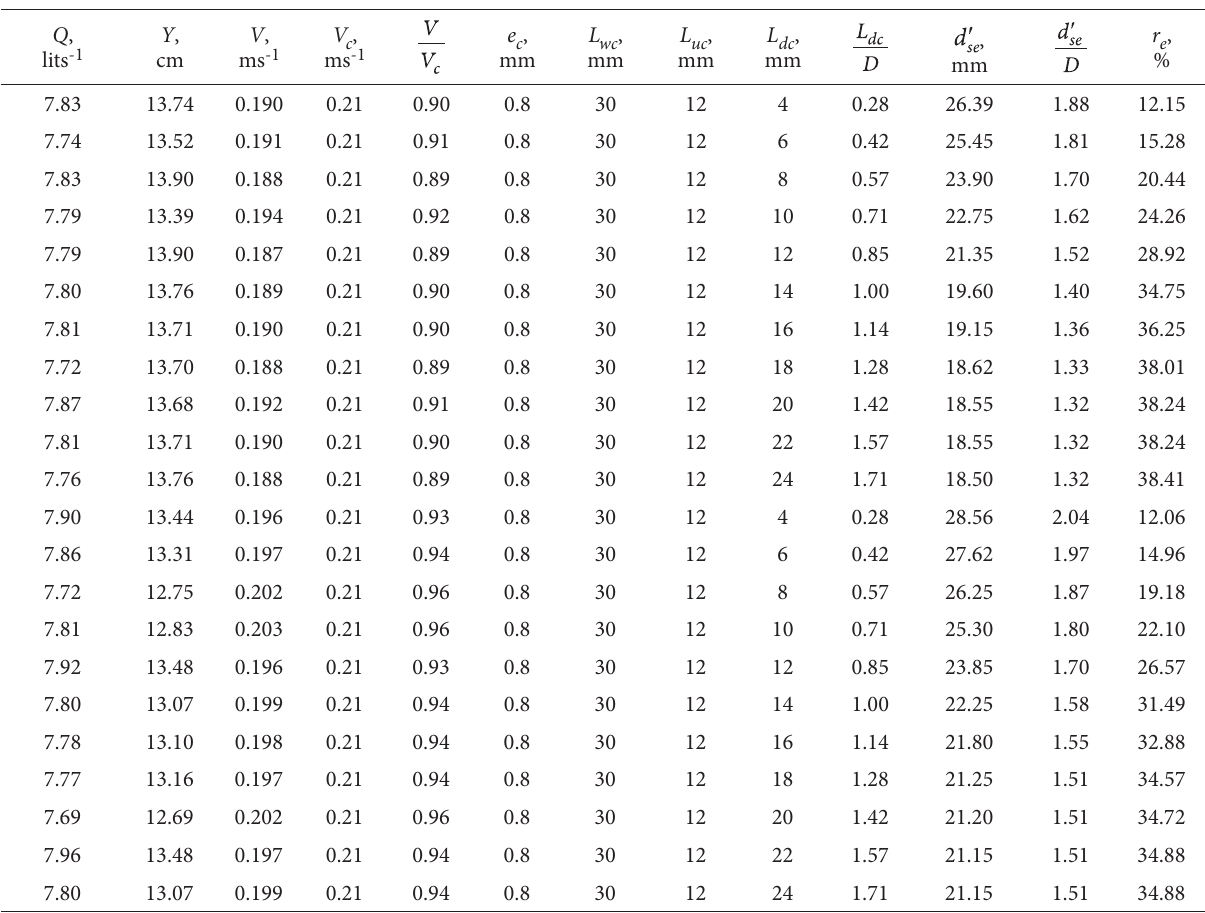
Table 4. Characteristics of experiments regarding bridge pier model scour in two-sided collar Q , lits -1